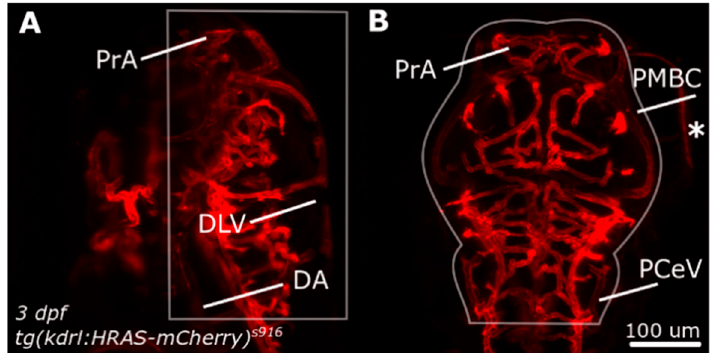
Figure 1. Dorsal cranial volume was measured in the region indicated by white outlines. ( A ) Dorsal-to-ventral boundary was established during image acquisition. ( B ) Lateral boundaries were defined by user to exclude structures outside the ROI, such as the eyes (asterisk). Figure reproduced with permission from [13] under licence 4466480468142.